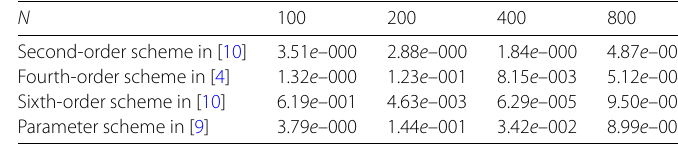
Table 5 Errors of different schemes ( k = 200)